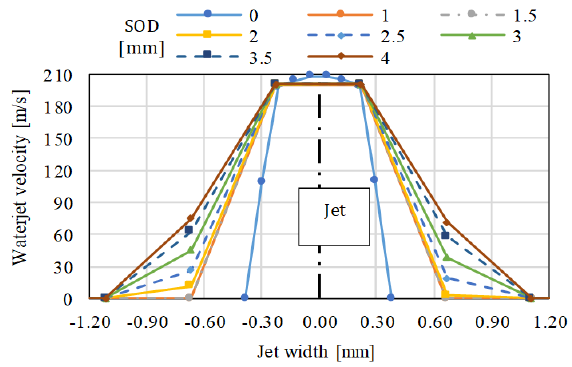
Figure 2. Water velocity distribution according to CFD simulation [11]